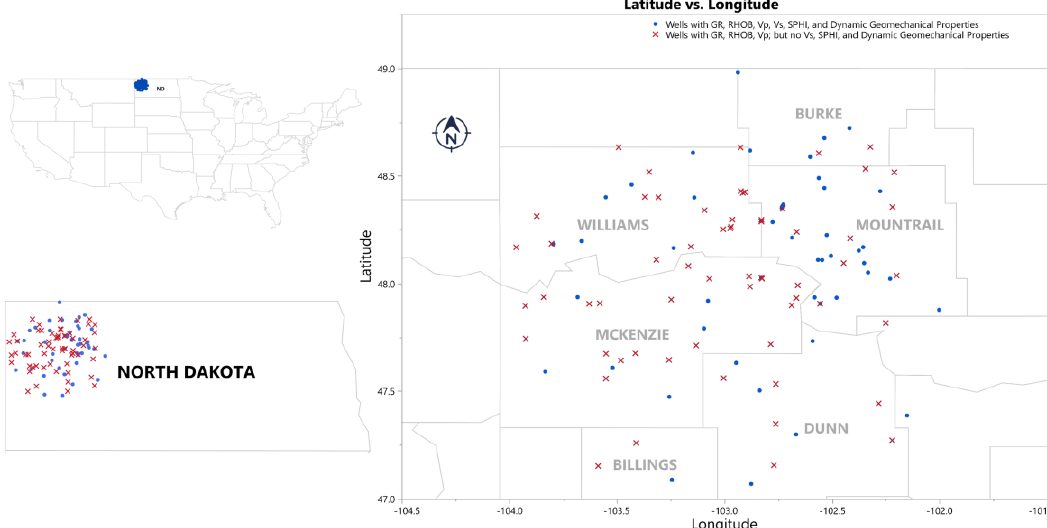
Figure 4. Bakken area in North Dakota, and the distribution of wells with respect to gamma ray, bulk density, compressional and shear wave velocity, sonic porosity, and geomechanical properties.